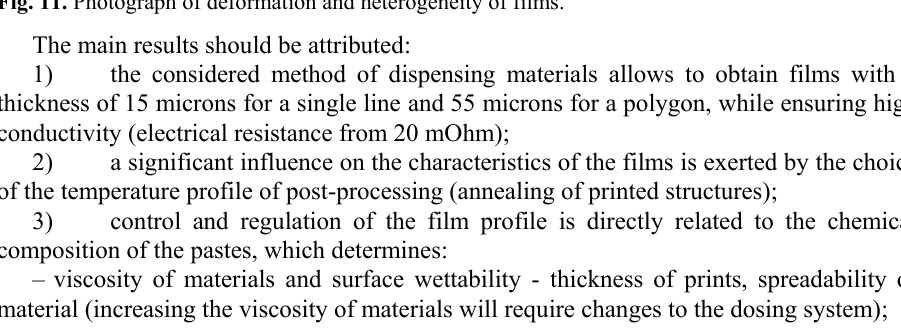
Fig. 11. Photograph of deformation and heterogeneity of